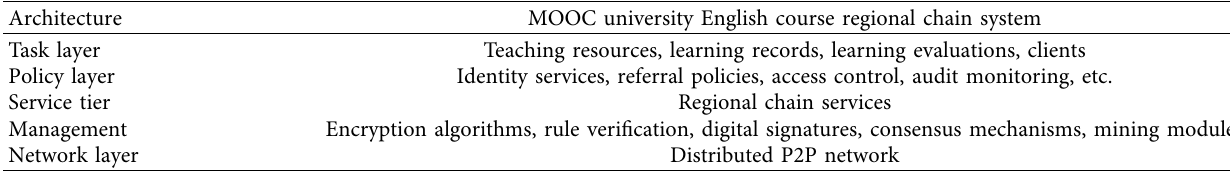
Table 2: Data block structure.